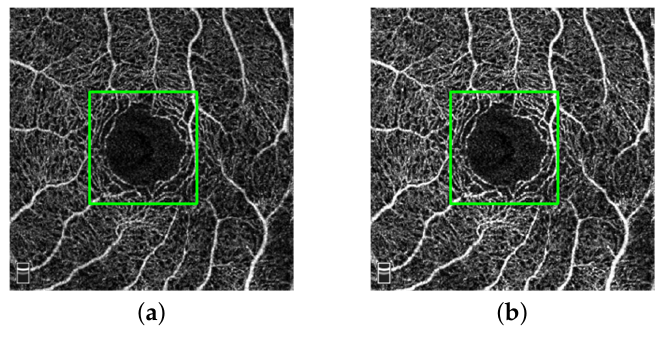
Figure 5. Original image ( a ) and enhanced image ( b